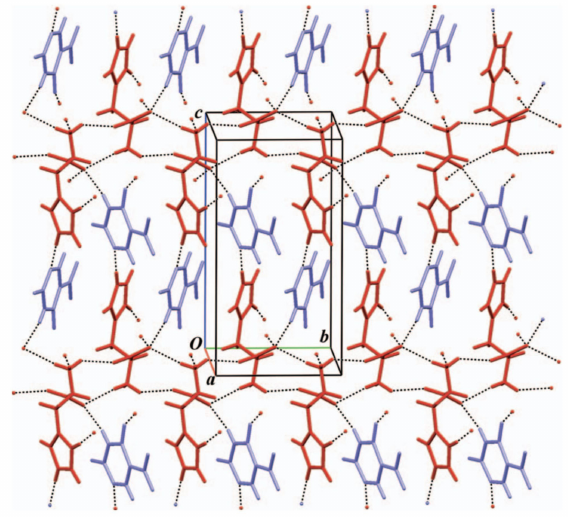
Figure 17. Guest-host structure of L-His+5NU − (XVIa) . The anions (blue) are encapsulated between the cationic layers (red) in a polar herringbone motif along the b axis. Reprinted with permission from Ref. [54], 2012, AIP publishing.